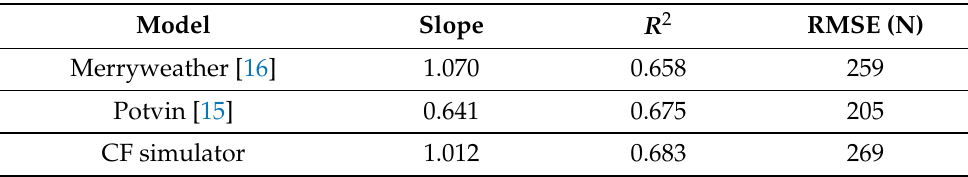
Figure 7. Regression analysis between the estimated compressive force (CF) obtained from ( a ) the model by Merryweather et al. (2009), ( b ) the CF simulator, and ( c ) the model by Potvin et al. (1997) with respect to the CF determined from invasive measurements; ( d ) Kruskal–Wallis test results: significance level ( p ≤ 0.001) among the distances between markers and y = x line estimated by the three models. Linear regression analysis between the estimated compressive force (CF) and invasive